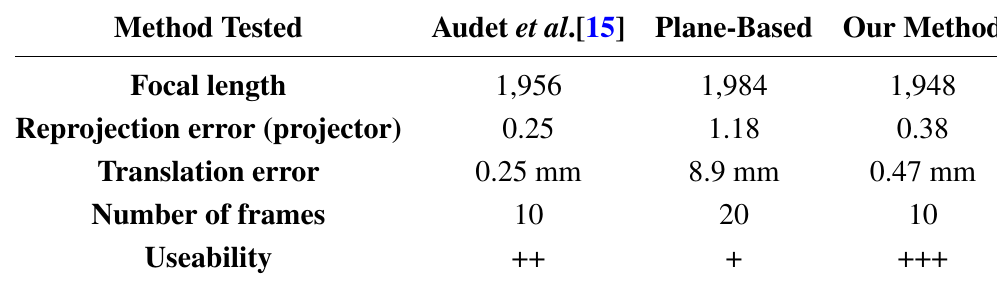
Table 1. Calibration